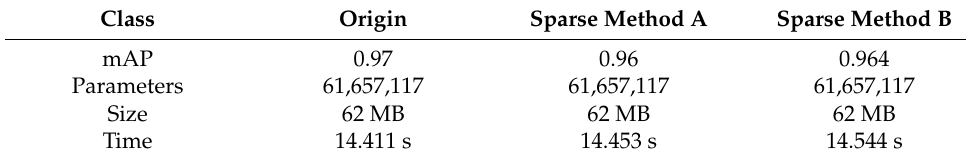
Table 3. Performance of the model before pruning on FPGA.